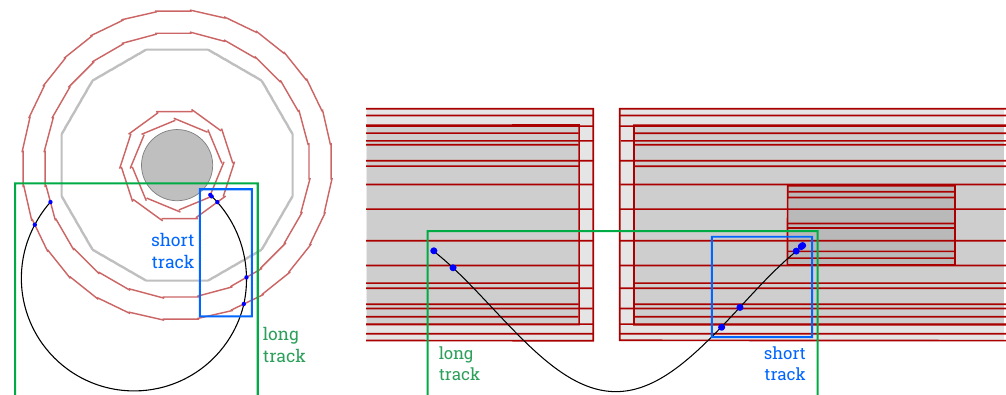
Figure 3: Event display of a simulated recurling track shown in transverse and longi- tudinal projection. The definitions of a reconstructed short and long track are shown.